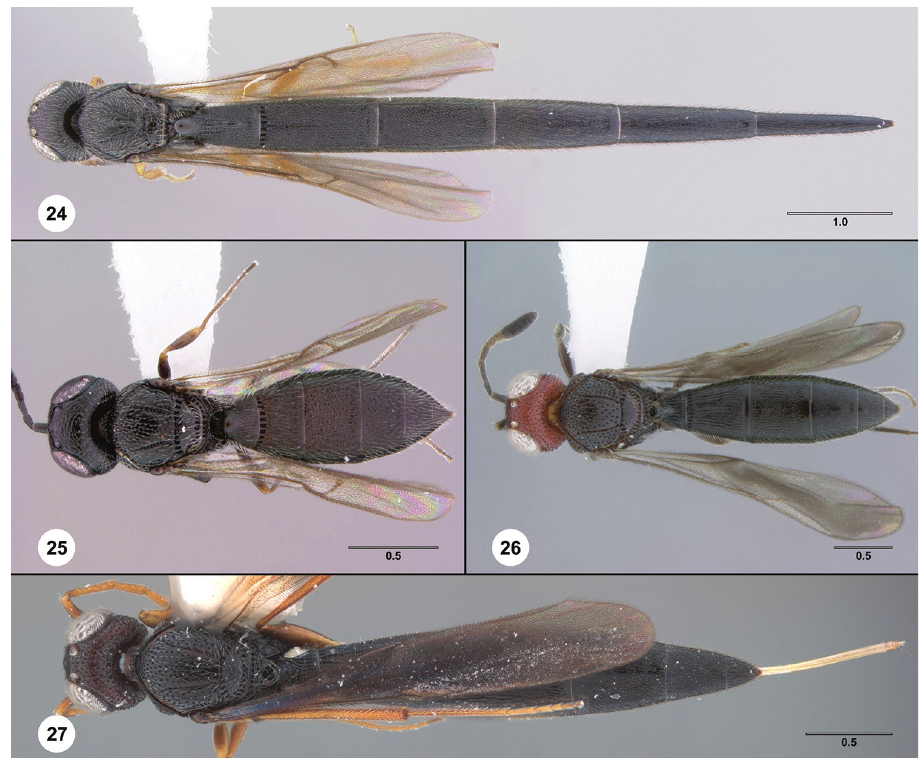
Figure 24–27. 24 Triteleia sp., female (OSUC 225498), dorsal view 25 Triteleia sp., female (OSUC 334149), dorsal view 26 Trichoteleia hemlyae (CASENT 2132833), female holotype, dorsal view 27 Tri- choteleia carinata (USNMENT01109593), female, dorsal view. Scale bars in